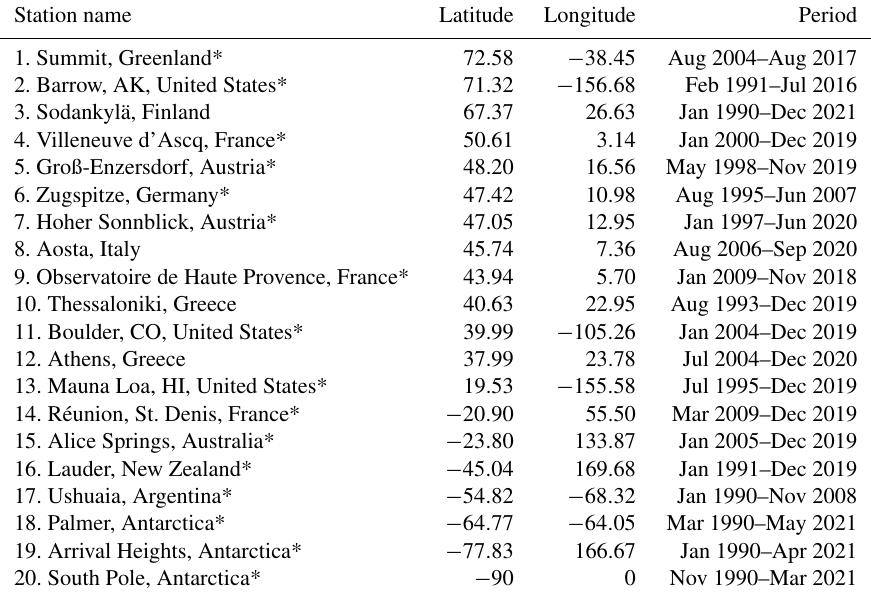
Table 1. Ground-based stations with long-term UV measurements used for the evaluation of EMAC CCM DNA-active irradiance simulations. Stations are listed from northern to southern high latitudes and are grouped as follows: 3 stations at latitudes greater than 55 ◦ N, 13 stations between 50 ◦ N–50 ◦ S, and 4 stations at latitudes greater than 55 ◦